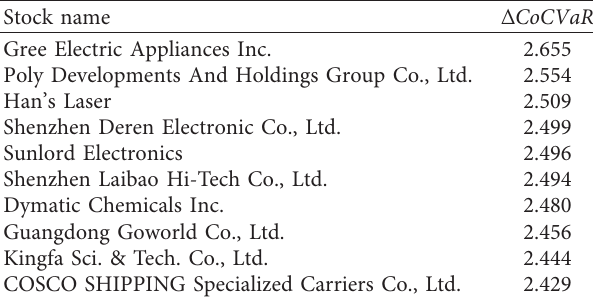
Table 4: 10 stocks with the smallest ∆ CoCVaR .